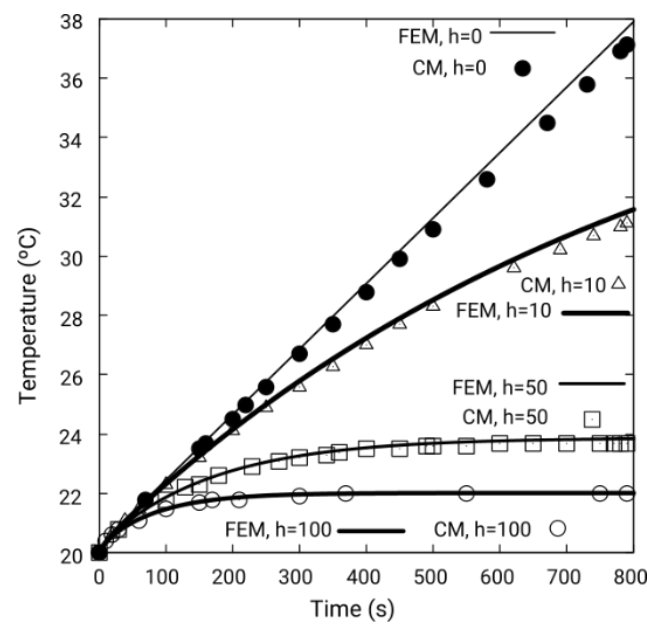
Figure 11. Comparison of the transient temperature regime in point PA of Figure 8 for h eff = 0, 10, 50 and 100 W/m 2 K , using CM and FEM, for w r = 11 rad/s and d = 6 mm, for a non-uniform heat power distribution. The results by both methods are practically coincident.